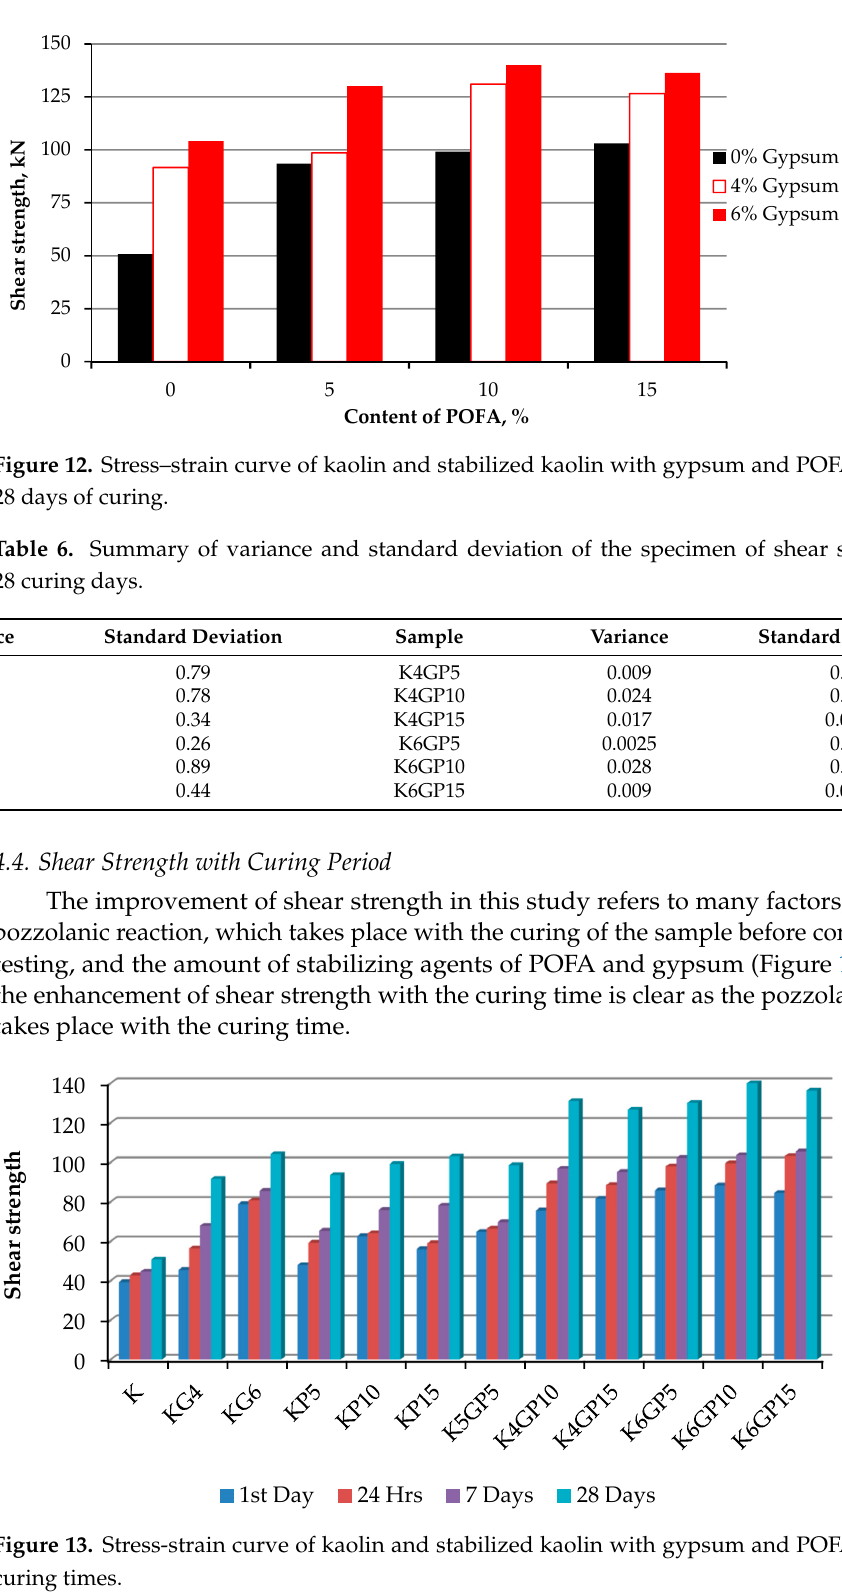
Figure 13. Stress-strain curve of kaolin and stabilized kaolin with gypsum and POFA at different curing times.